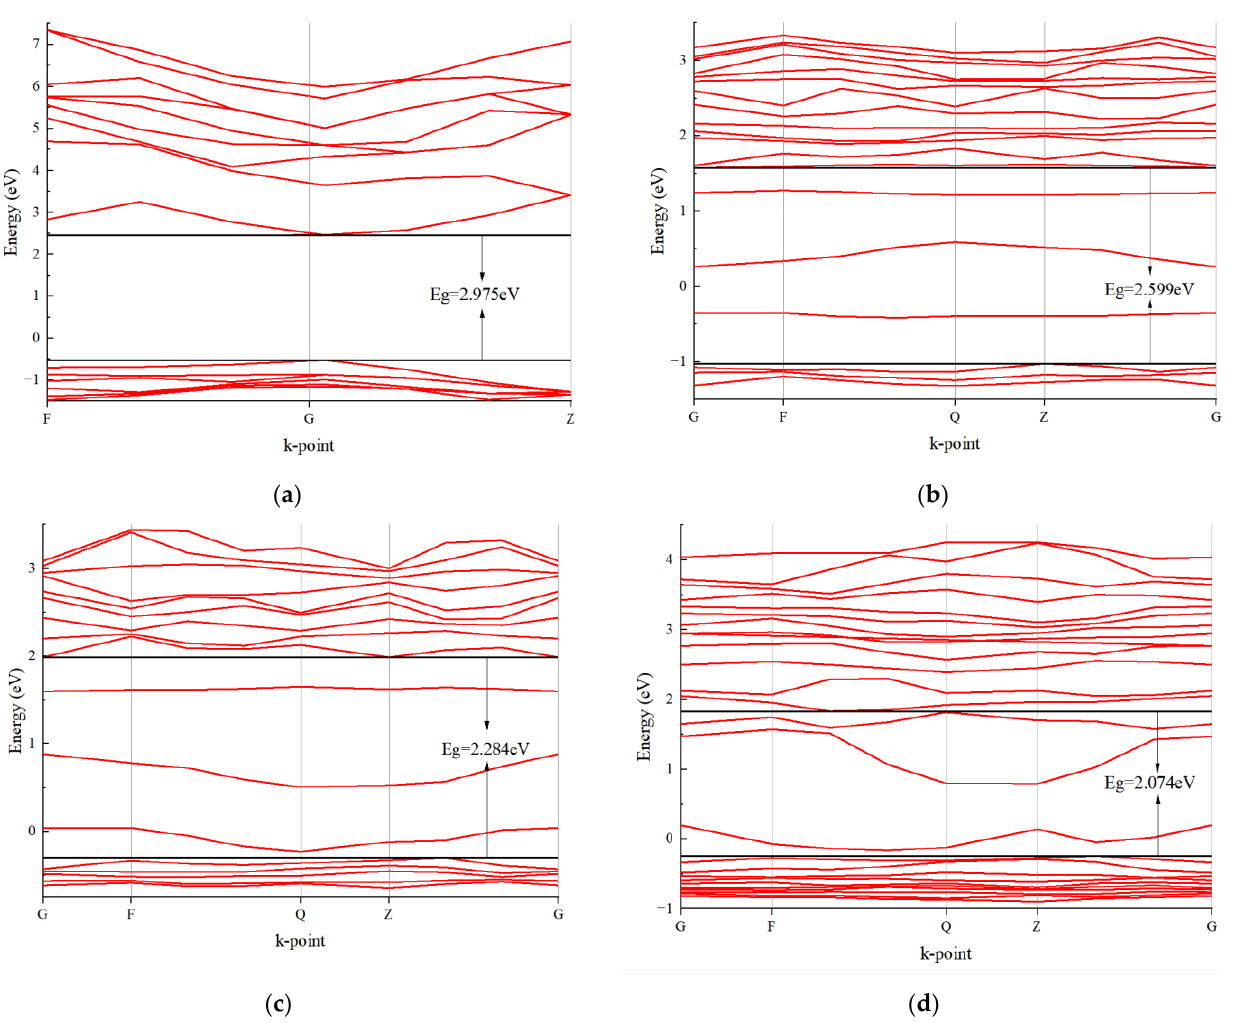
Figure 9. Band structure near the Fermi level. ( a ) LaNiO 3 ; ( b ) LaNiO 3−σ ; ( c ) La 0.875 Sr 0.125 NiO 3 ; ( d ) La 0.875 Sr 0.125 NiO 3−σ .